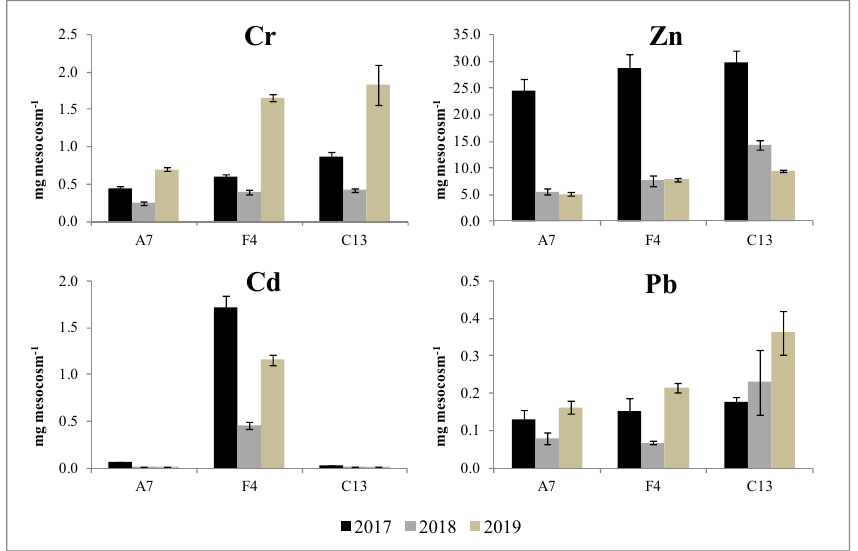
Figure 4. PTE uptake by Indian mustard (mg d.w. mesocosm − 1 ). The corresponding analysis of variance is given in Table S3. Error bars represent standard deviations.